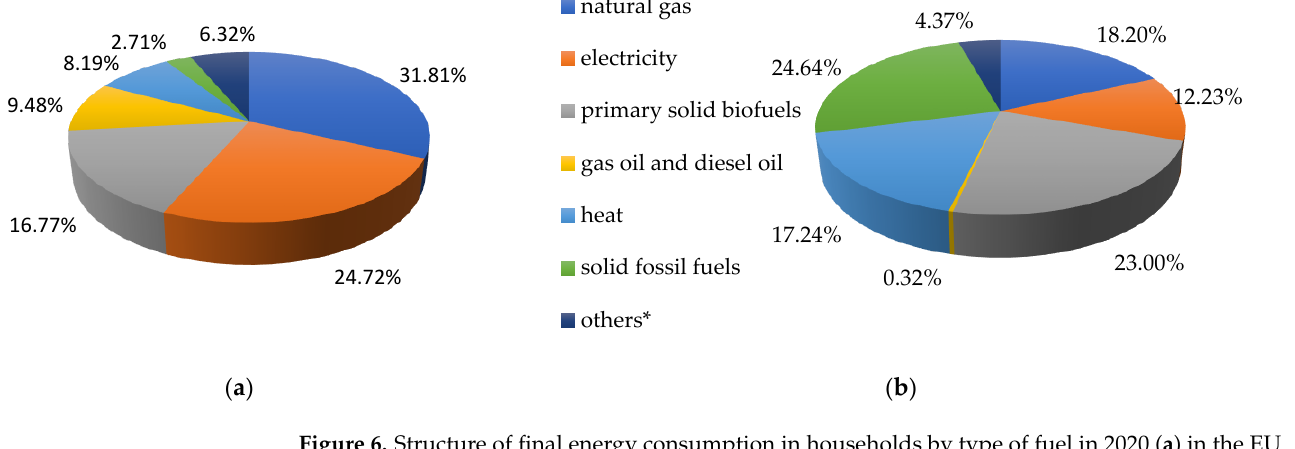
Figure 6. Structure of final energy consumption in households by type of fuel in 2020 ( a ) in the EU and ( b ) in Poland. Own research based on EUROSTAT [57]. Others* — liquefied petroleum gases, ambient heat (heat pumps), other kerosene, solar thermal.